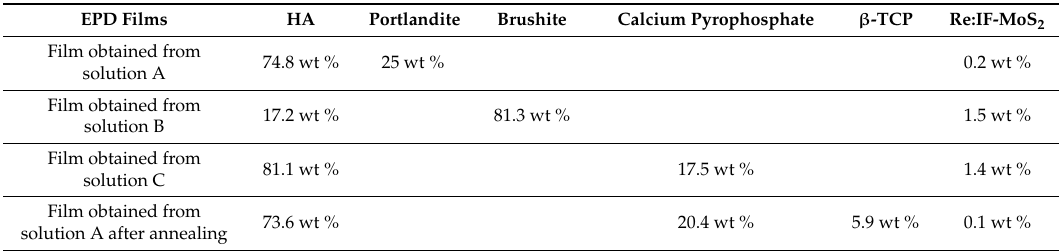
Table 1. Composition of the films deposited from different solutions determined from the XRD analysis.